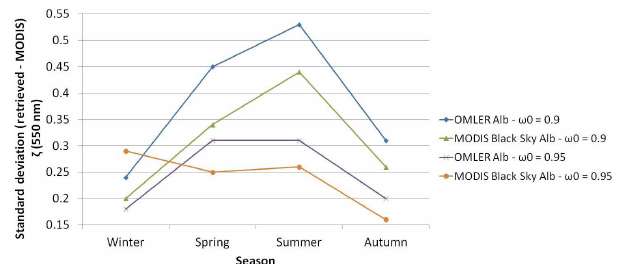
Figure 12. Standard deviation of the differences between OMI τ( 550nm ) retrievals and MODIS τ( 550nm ) from Dark Target land algorithm over land for all the individual cloud-free observations over north-east Asia. The retrievals are obtained over 3 years, 2005– 2007, and for the four seasons. Aerosol single scattering albedo ω 0 = 0.95 and ω 0 = 0.9 are assumed. OMLER and MODIS black- sky surface albedo is alternatively